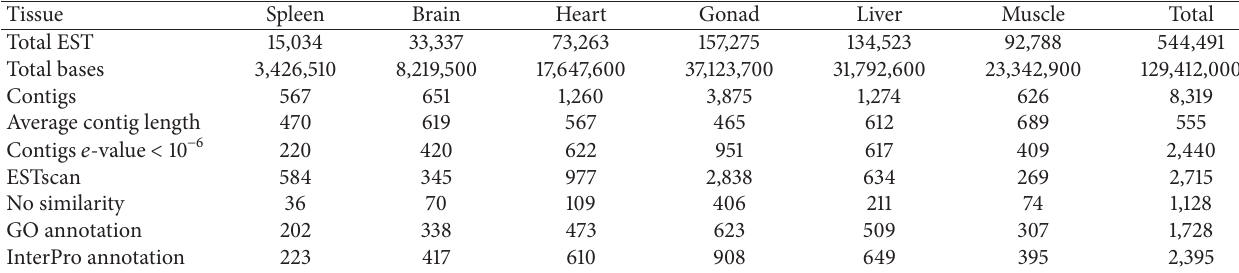
Table 2: Global statistics for each of the nonnormalized libraries using Newbler